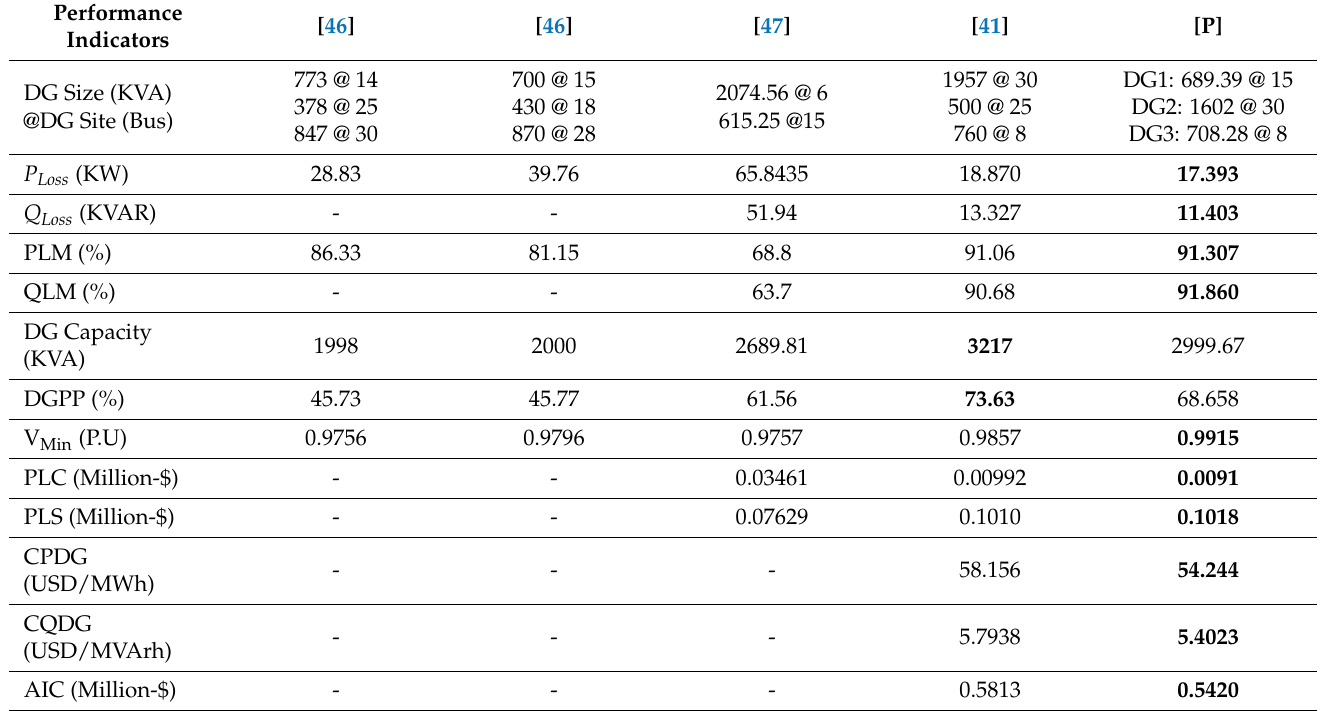
Table 29. Comparisons of results with C1/S1 under NL for the 33-bus MDN (DG@LPF =